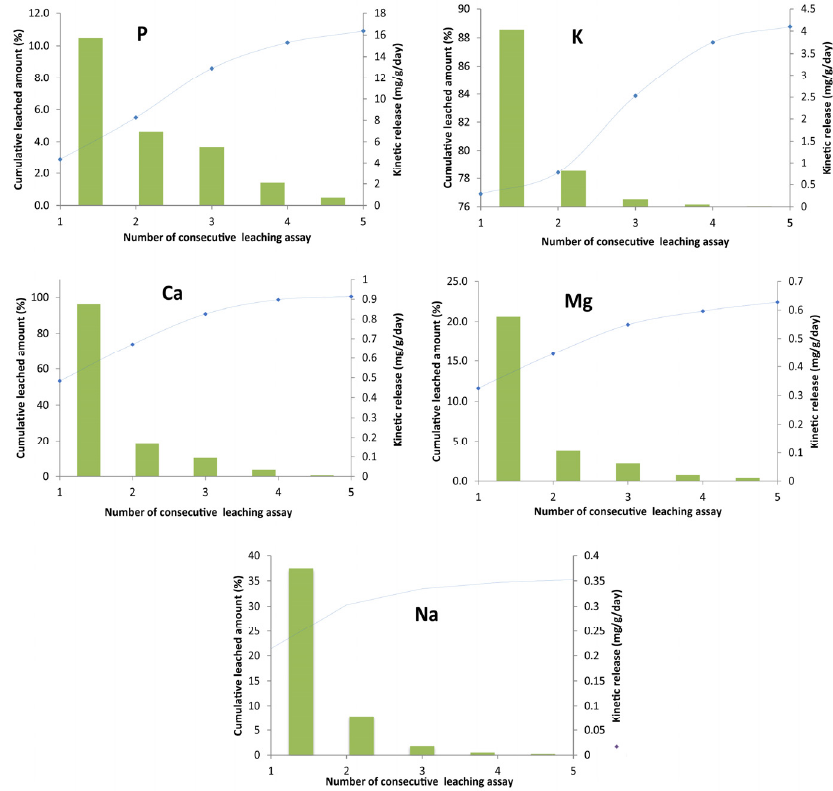
Figure 10. The effects of successive leaching assays on the release of Na, K, Mg, Ca, and P from FS treated.